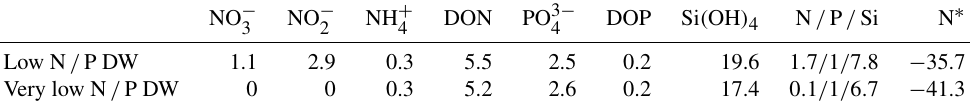
Table 1. Concentrations of nitrate, nitrite, ammonium, dissolved organic nitrogen (DON), and dissolved organic phosphorus (DOP), and silicate (micromoles per litre, hereafter µmolL − 1 ) in the two deep water batches and associated inorganic N / P / Si in comparison to a Redfield ratio of 16 / 1 / 16 (see the text for details), and the inorganic N deficit calculated as N ∗ = DIN − 16 × PO 3 − sum of NO − NO − and NH + . 3 2 4